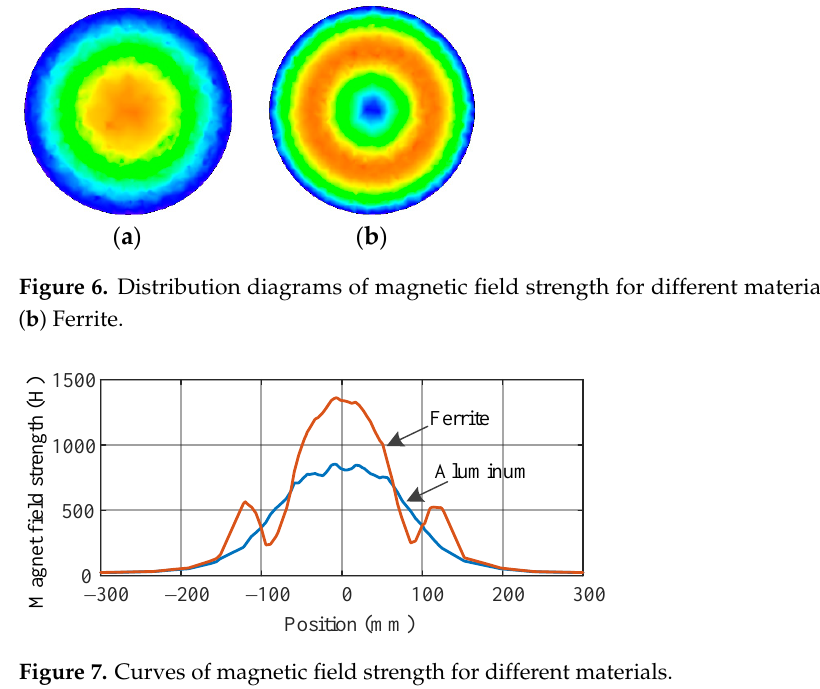
Figure 7. Curves of magnetic field strength for different